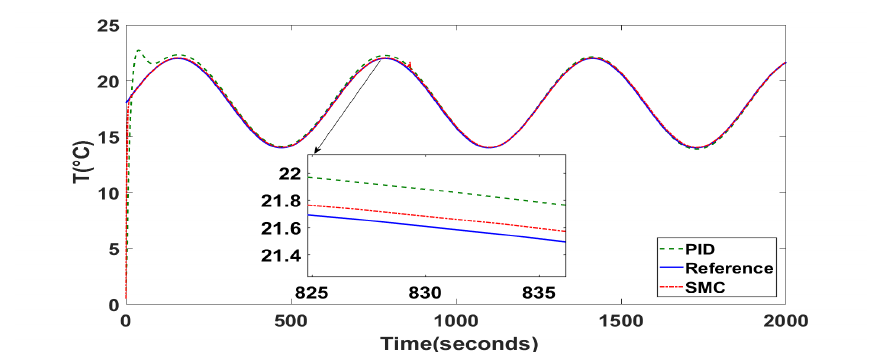
Figure 6. Tracking result of the PID and SMC for Zone 1 sine wave reference.